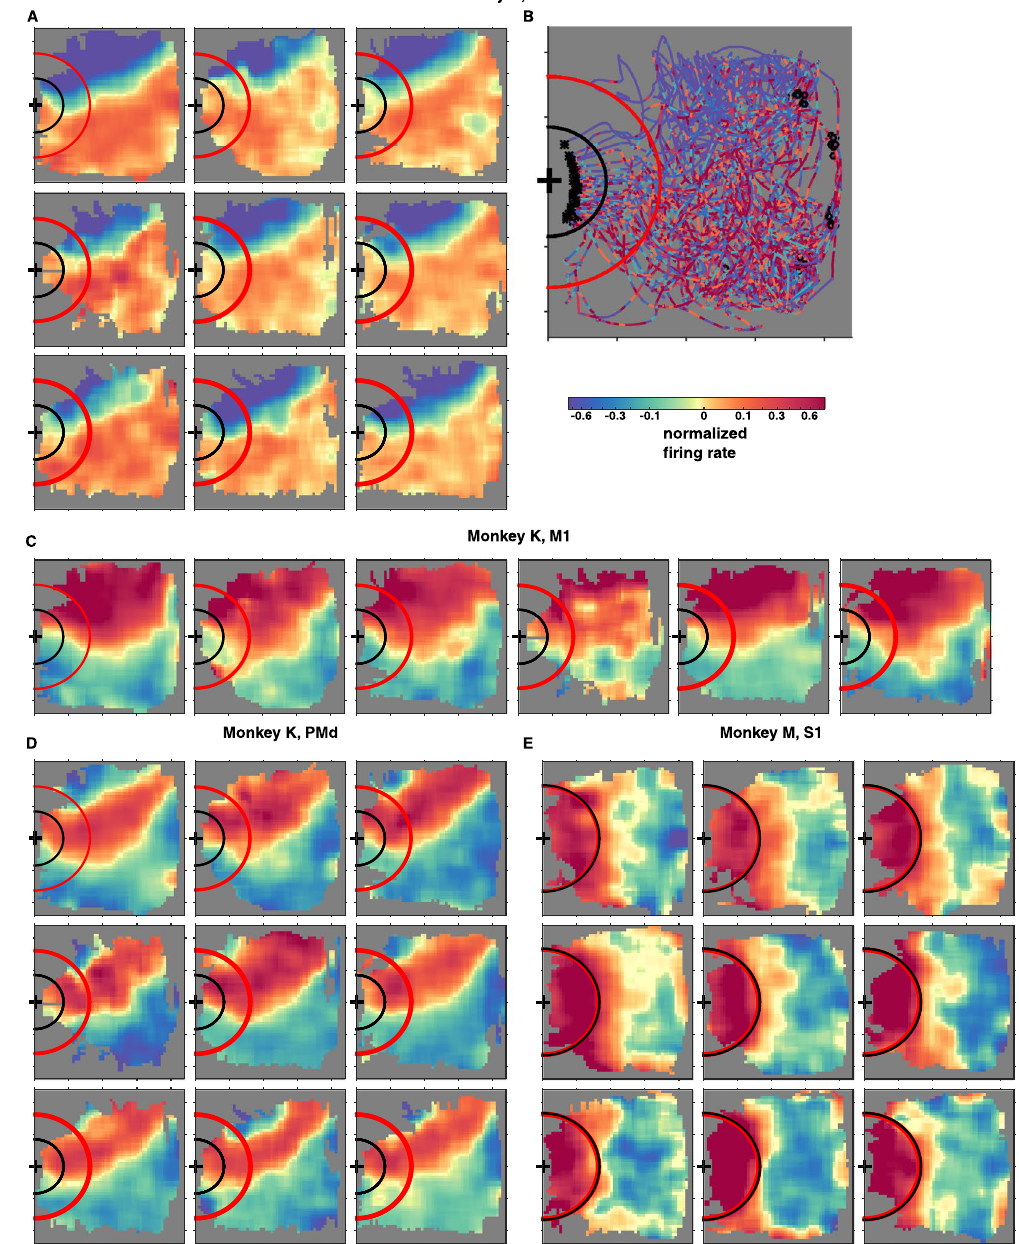
Figure 4. Individual neurons with consistent position tuning across multiple sessions. ( A ) The position-tuning diagram of monkey K’s PMd neuron shown in Fig. 1C for all nine experimental sessions. Session ordered from left to right, then top to bottom. The first session displayed corresponds to Fig. 1C. ( B ) Sample brain-controlled navigation trajectories for the same session as the data shown in Fig. 1C. Colors represent normalized firing rates along the trajectories. Black ‘ * ‘ mark the location at the end of each trial, and black ‘o’ mark the starting locations of each trial. (C) The position-tuning diagram of monkey K’s M1 neuron shown in Fig. 1B, for the first six experimental sessions. Session number increases from left to right. The first session is the same as shown in Fig. 1B. ( D ) Position tuning diagrams of monkey K’s PMd neuron for all nine experimental sessions. Session ordered from left to right, then top to bottom. (E) Position tuning diagrams of monkey M’s S1 neuron shown in Fig. 1F for nine consecutive experimental sessions, just before the session shown in Fig. 1F. Session ordered from left to right, then top to